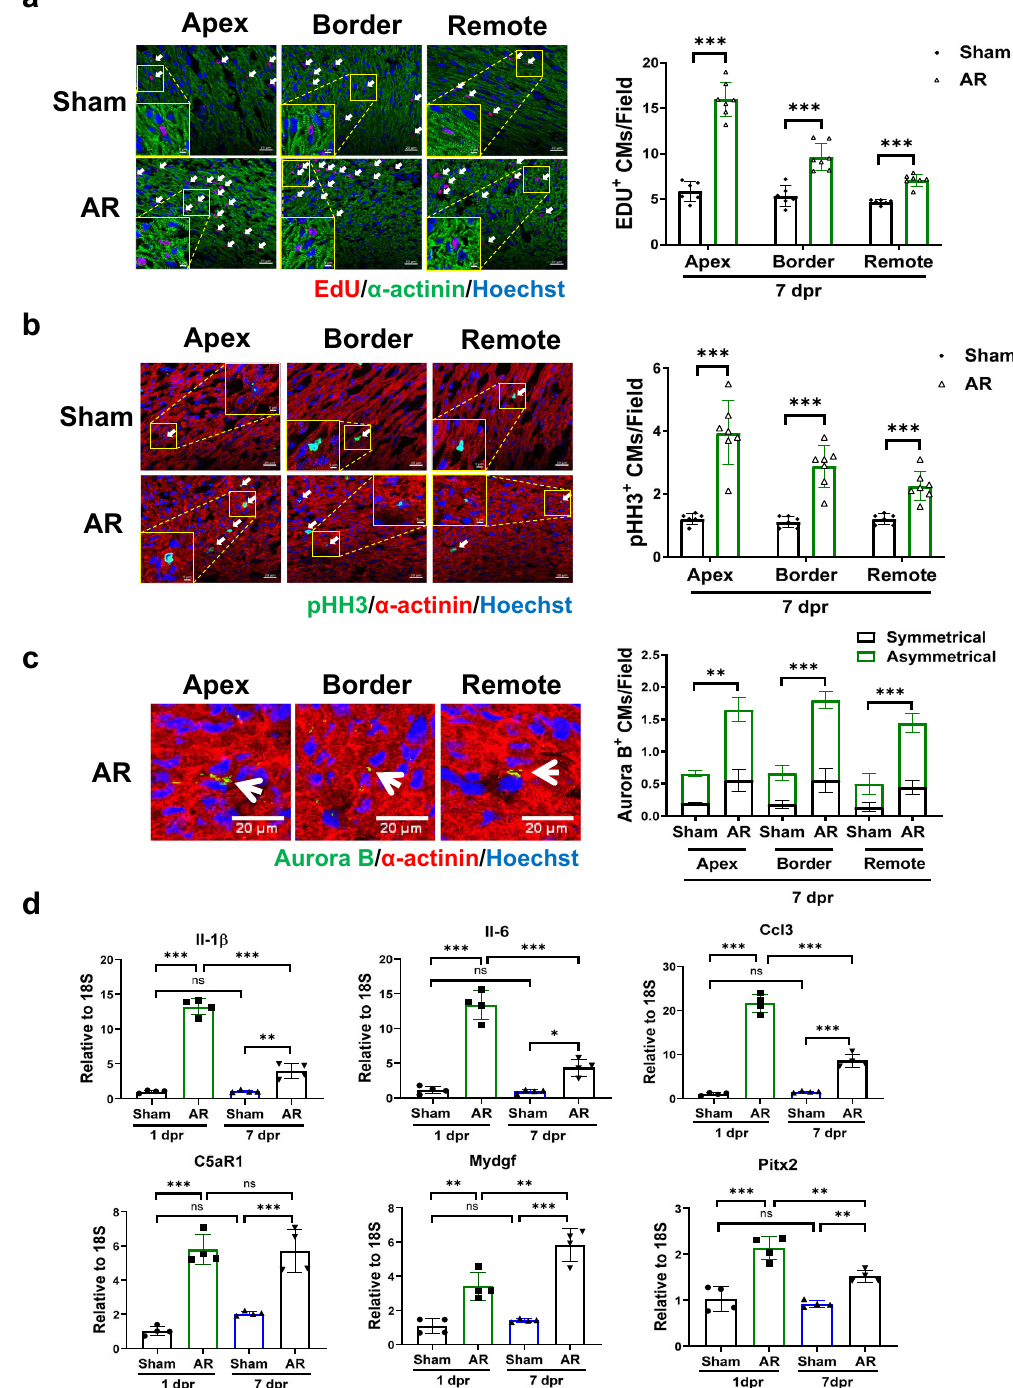
Fig. 4 Regenerative responses after modi fi ed apical resection surgery in 1-day-old neonatal mice. Co-immuno fl uorescent staining for α -actinin and EdU ( a ) or phospho-histone H3 (pHH3) ( b ) in sham and apical resection (AR) hearts at 7 days post resection (7 dpr) ( n = 6-7). Scale bar = 20 μ m. A selected area with a higher magni fi cation (Scale bar = 5 μ m) for each representative image was presented. c Co-immuno fl uorescent staining for α -actinin and Aurora B at 7 dpr to evaluate Aurora B-kinase expression at the cleavage furrow between two cardiomyocytes ( n = 4). The representative asymmetrical (in the apex and remote region) and symmetrical (in the border region) Aurora B positive cardiomyocytes were indicated by white arrows. Scale bar = 20 μ m. d Quantitative PCR for in fl ammatory and immunomodulatory factors and myocardial pro-proliferative factors in sham and AR hearts at 1 dpr and 7 dpr ( n = 4). ** P < 0.01; *** P < 0.001; ns not signi fi cant. All data are expressed as means ± SD.